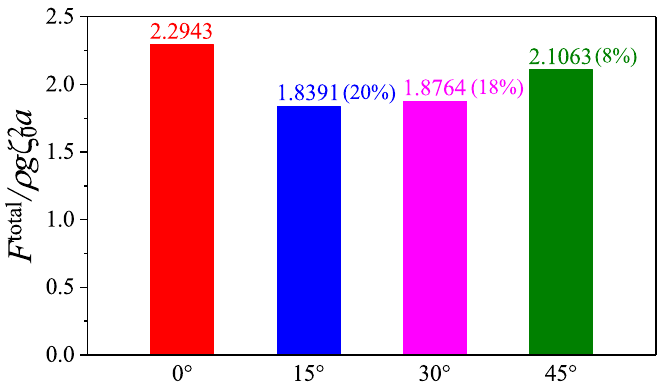
Figure 13. The total wave drift forces on the whole structure with different wave-approach angles and the corresponding decrement percentage at k 0 a =